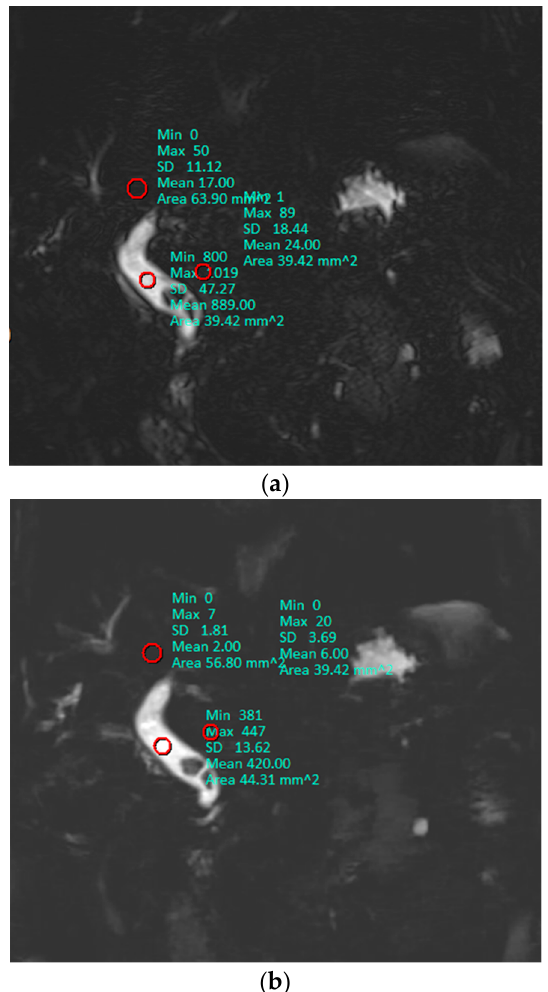
Figure 1. A representative slice used in each patient for quantitative analysis. The mean value of ROI (red circles) represents signal intensity (SI) and standard deviation (SD) was used as image noise. Signal-to-noise ratio, contrast ratio, and contrast-to-noise ratio were 18.81, 0.95, and 25.40 on conventional MRCP ( a ), and 30.84, 0.97, and 43.02 on optimized BH-CS-MRCP ( b ), respectively.